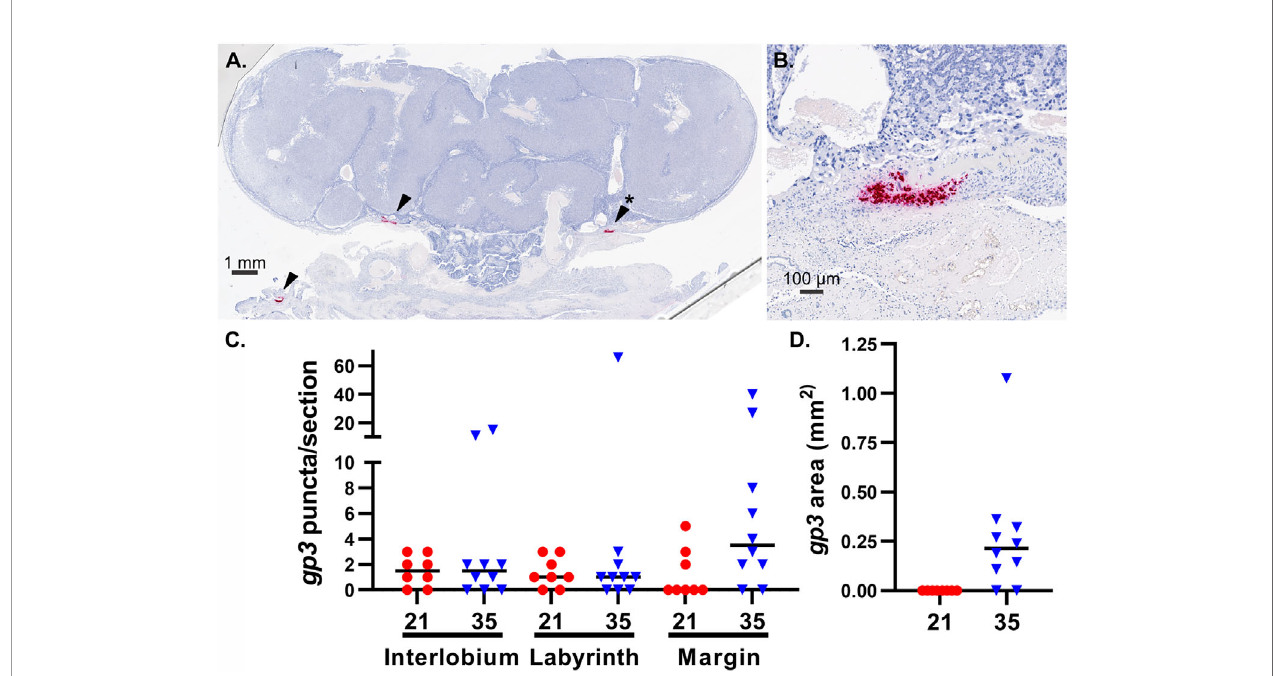
FIGURE 5 | GPCMV localization in infected placenta. An RNAscope probe speci fi c to GPCMV gp3 was used to detect infected cells in sections of placenta by in situ hybridization. (A) A representative section of a placenta from a dam infected at 35 dGA, illustrating large areas of GPCMV infected cells in the junctional zone and decidua (red, indicated by arrows). (B) High-magni fi cation image of infected cells in the junctional zone (*). (C) gp3 + puncta, representing individual infected cells or small groups of infected cells, were counted based on their localization in the placenta after maternal infection at 21 or 35 dGA and collection at 21 dpi. (D) The measured area of gp3 + stained cells in the junctional zone of placentas is